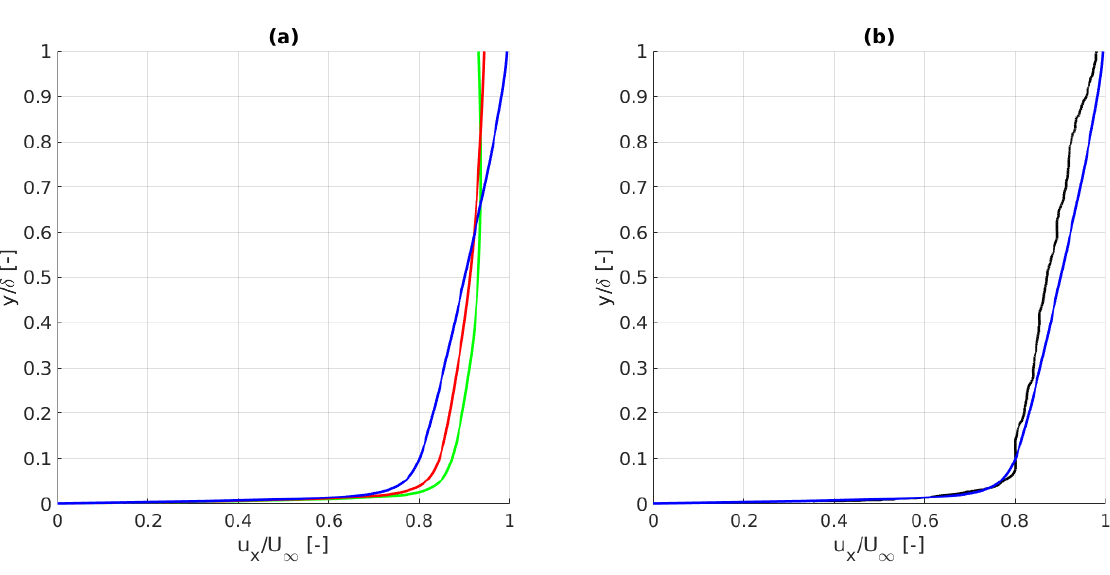
Figure 6. Comparison of the normalized streamwise velocity profile at the 10H downstream plane position and spanwise position of z = 0 mm, corresponding to the Rectangular VG case. Vertical coordinate y normalized with the experimental boundary layer thickness of δ = 20 mm. ( a ) CFD curves for three different meshes: coarse (green), medium (red), fine (blue). ( b ) Boundary layer (BL) velocity profiles of the fine mesh (blue) versus the experimental one